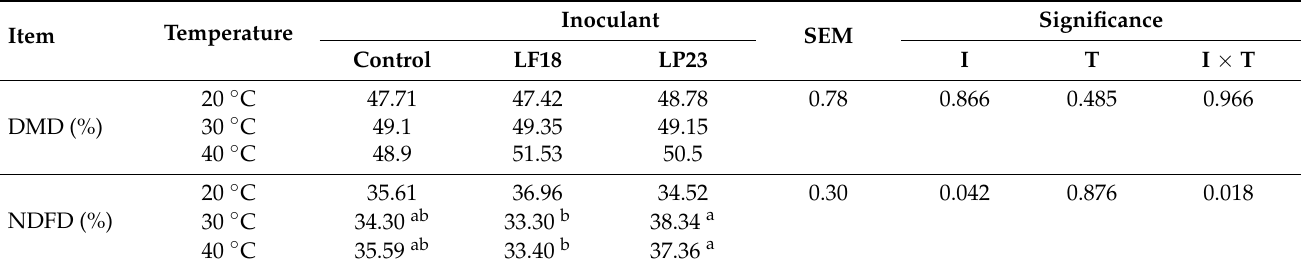
Table 3. In vitro digestibility of sorghum silages.